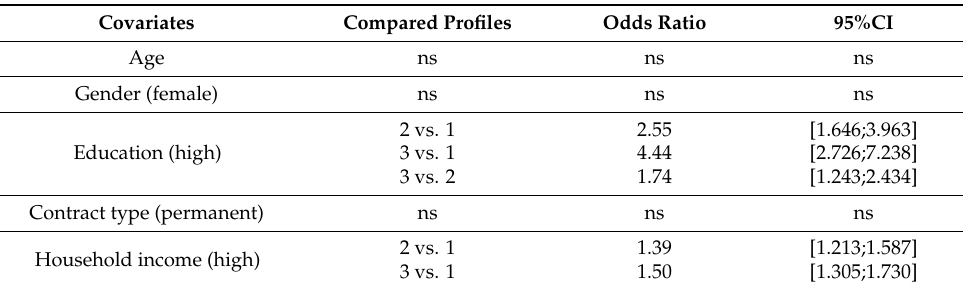
Table A2. Covariates of the latent profile membership at Time 1.